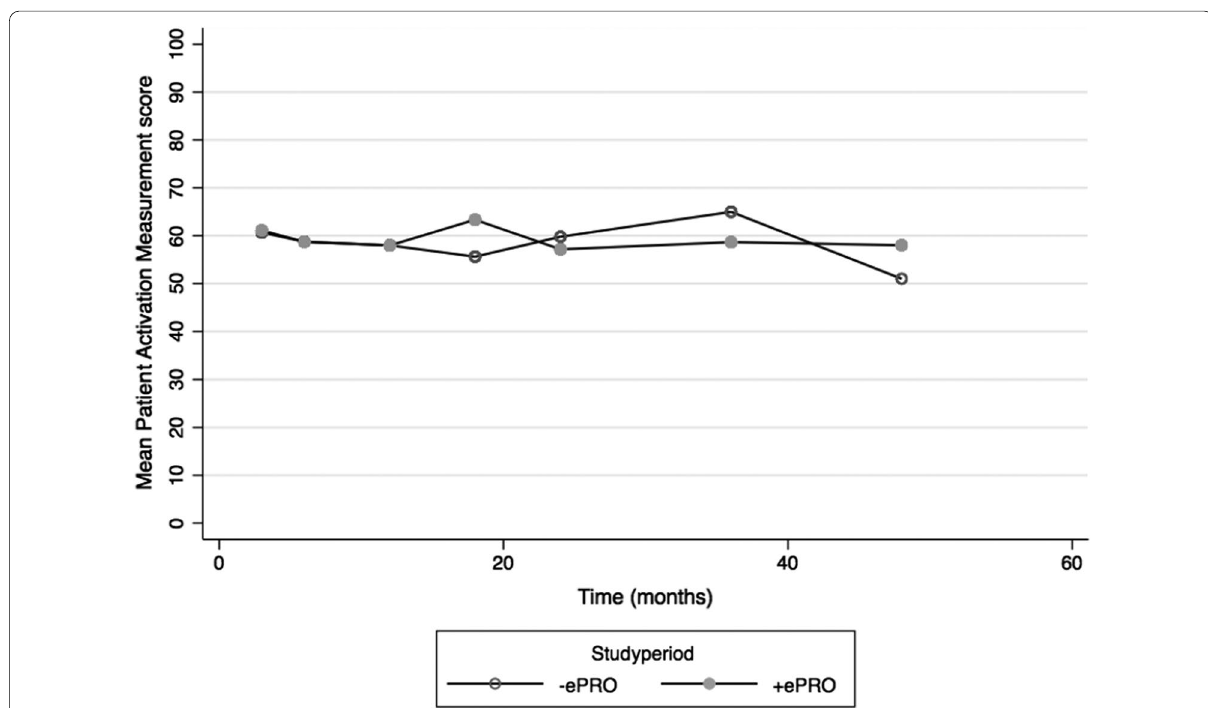
Fig. 4 Raw Patient Activation Measurement (PAM) scores assessed after each follow-up consultation, i.e. 3, 6, 12, 18, 24, 36 and 48 months postoperatively. Each response is grouped according to the period with no electronic Patient-reported Outcomes